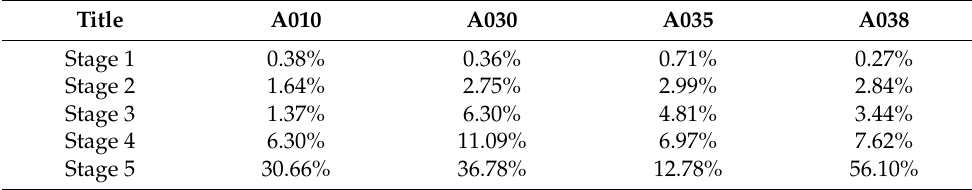
Table 3. Voids in LEP layer.